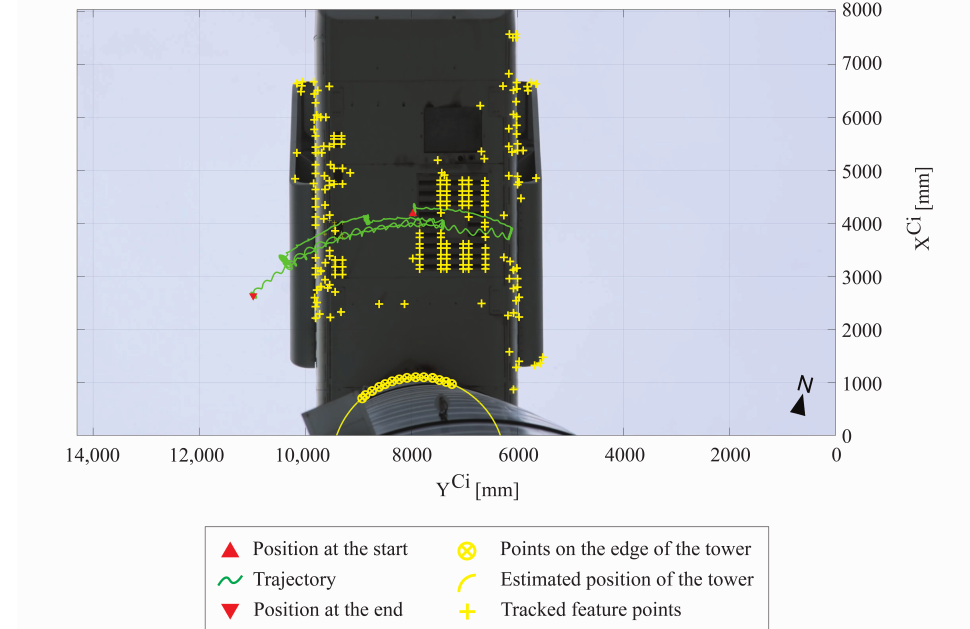
Figure 7. Example of the feature point tracking of the video recording. The image of the first recorded frame is overlayed with yellow crosses (+) and circles (o). The first ones are the automatically detected feature points, while the latter ones are the manually selected points on the intersection between the tower and the nacelle. The green line shows the trajectory derived over the period of 20min for the